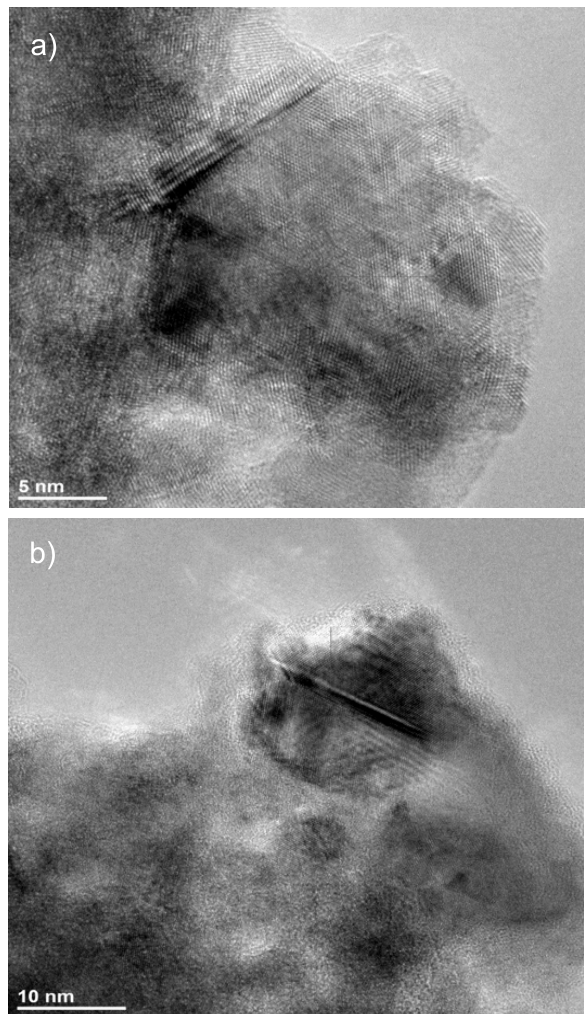
Figure 5. HRTEM images of Pd-modified Ni catalysts for ( a ) NiPd 0.05 TSNH 2 and ( b ) NiPd 0.13 TSNH 2 .